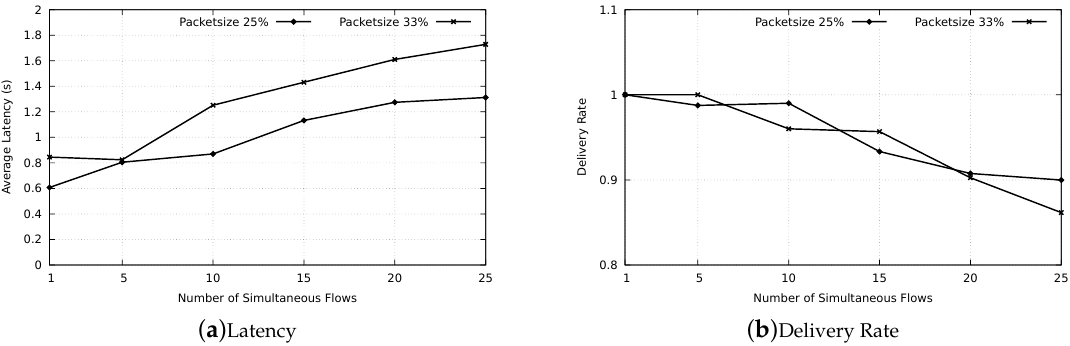
Figure 15. End-to-end latency ( a ) and delivery rate ( b ) with 1,5,10,15,20,25 different flows dispatched within a ∆ time